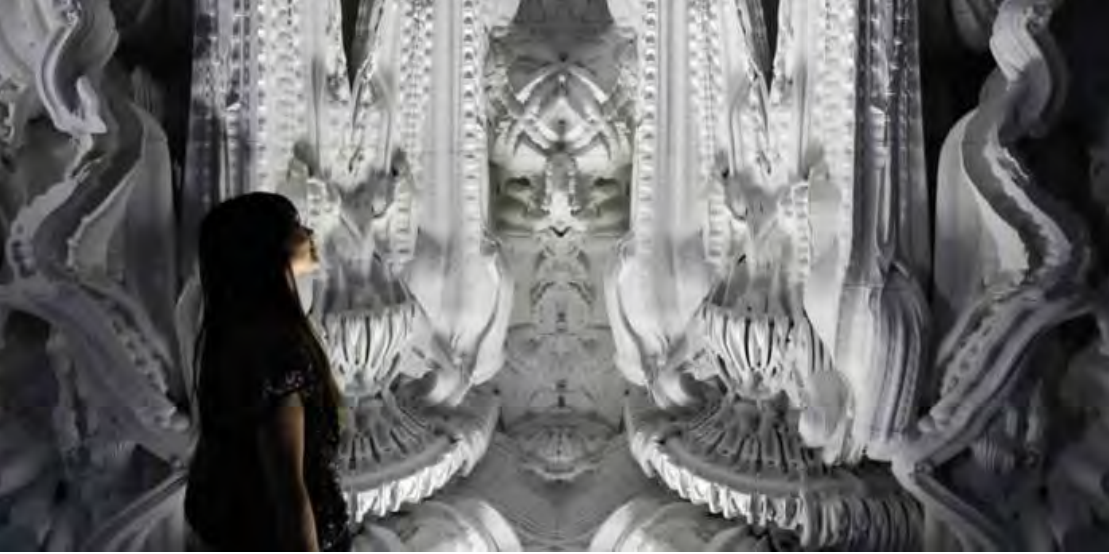
Figure 7. Digital Grotesque structure with a perplexing level of